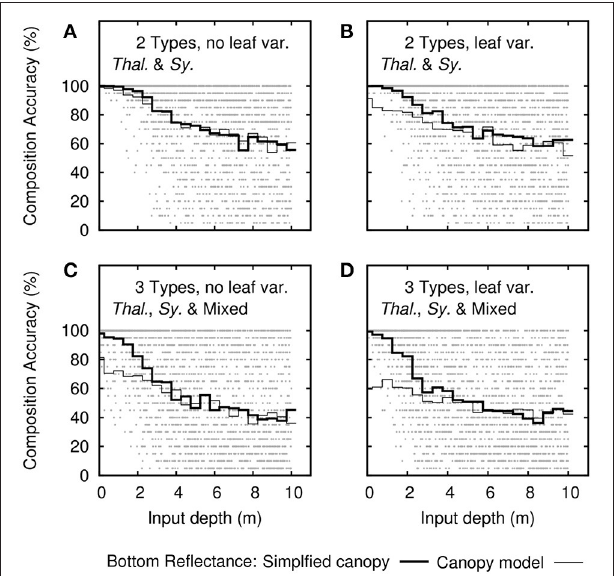
FIGURE 9 | Sensitivity analysis results for the accuracy of canopy composition type determination as function of depth. Each dot is the overall accuracy from the uncertainty propagation (20 repeats) of each of the 2,500 noise-perturbed self-inversions. Dark lines are the mean accuracy binned in steps of 0.5m. Thin lines are the mean accuracy when input bottom reflectances are drawn directly from the canopy model results. Treatments include (A,B) the model of two bottom types and (C,D) three bottom types. Each is repeated (B,D) with and (A,C) without leaf level variance.